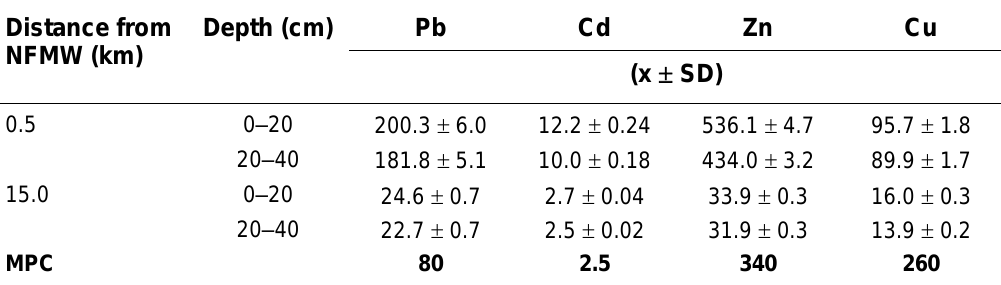
Content of Pb, Cu, Zn, and Cd (mg/kg) in Soils Sampled from the